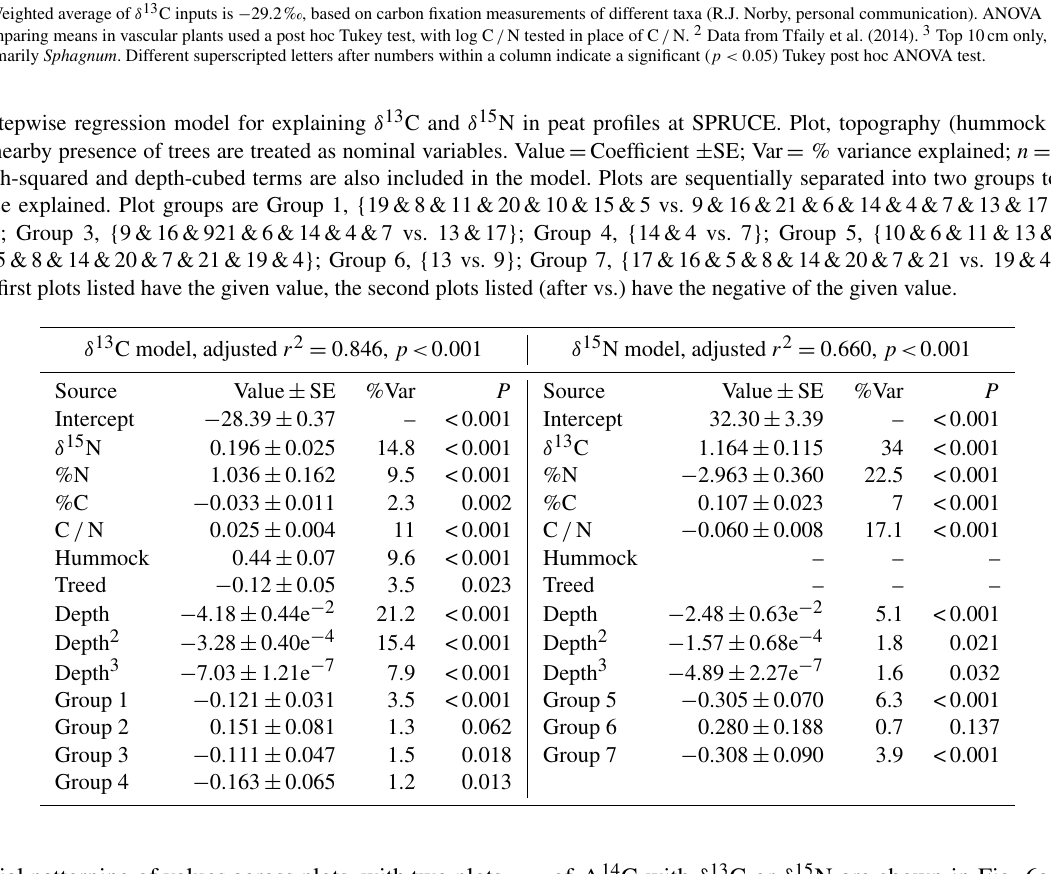
Table 3. Stepwise regression model for explaining δ 13 C and δ 15 N in peat profiles at SPRUCE. Plot, topography (hummock versus hol- low), and nearby presence of trees are treated as nominal variables. Value = Coefficient ± SE; Var = % variance explained; n = 238. Depth incm, depth-squared and depth-cubed terms are also included in the model. Plots are sequentially separated into two groups to maximize the variance explained. Plot groups are Group 1, {19&8&11&20&10&15&5 vs. 9&16&21&6&14&4&7&13&17}; Group 2,